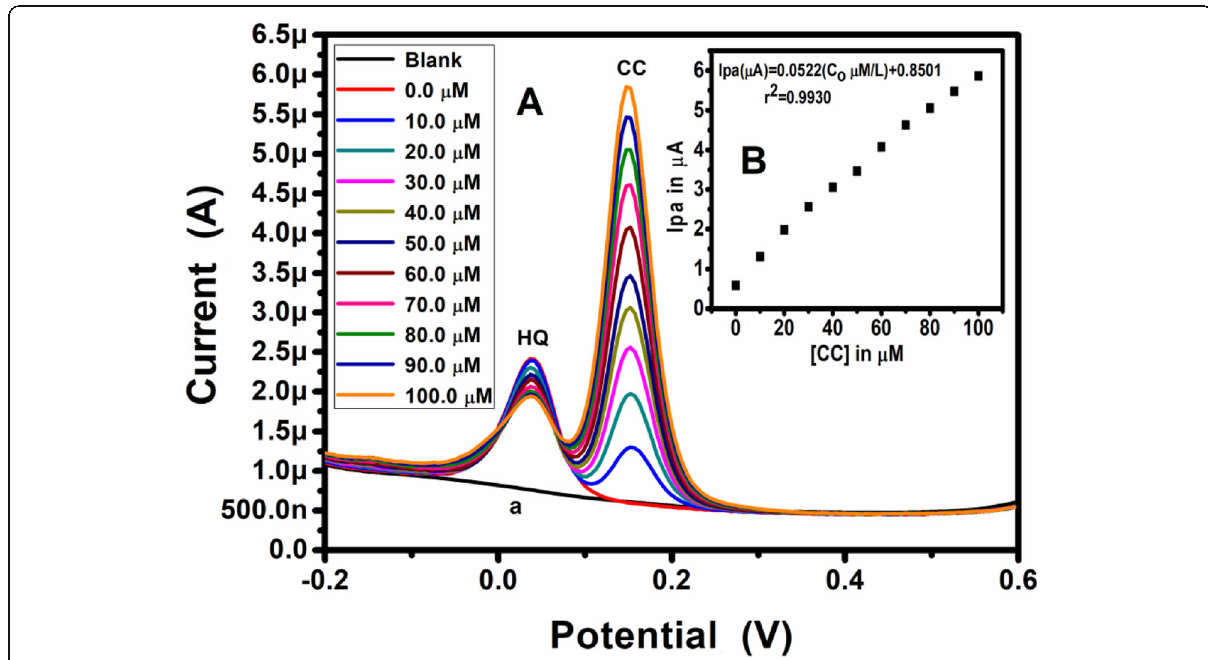
Fig. 9 a DPVs of varying concentrations of CC in presence of 20.0 μ M HQ at ALR/GCE. b Linear plot of Ipa versus concentration of